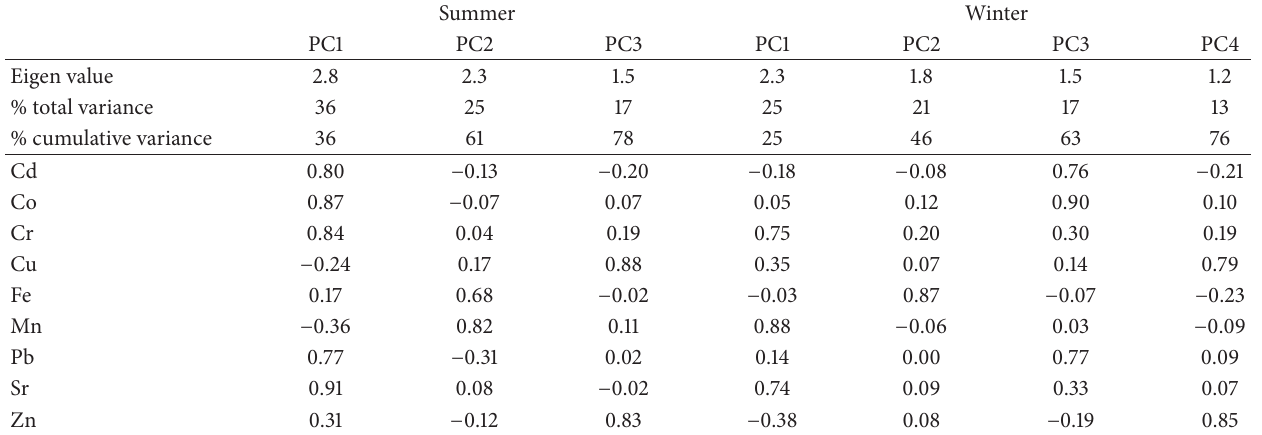
Table 3: Principal component loadings of selected metals in soil in summer and